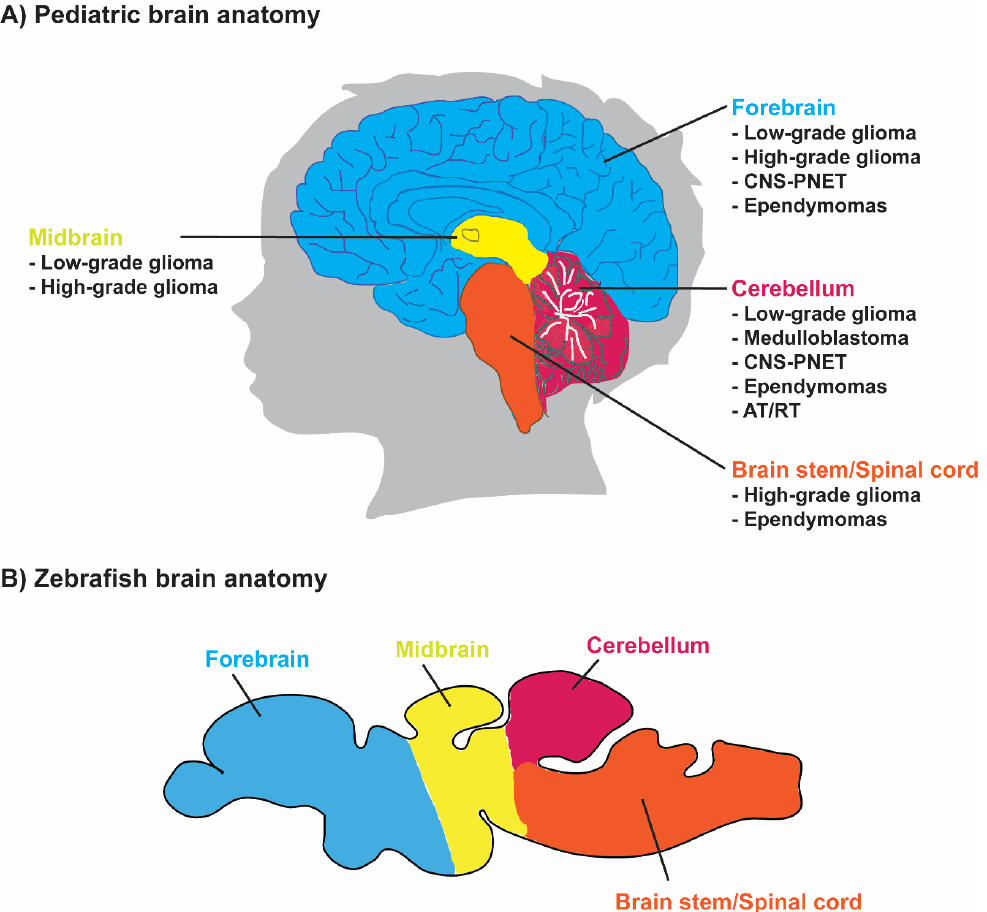
Figure 1. Paediatric brain and CNS tumour locations. ( A ) The paediatric brain tumour types and their location within the brain and CNS and ( B ) zebrafish brain anatomy [28] are shown. CNS-PNET,